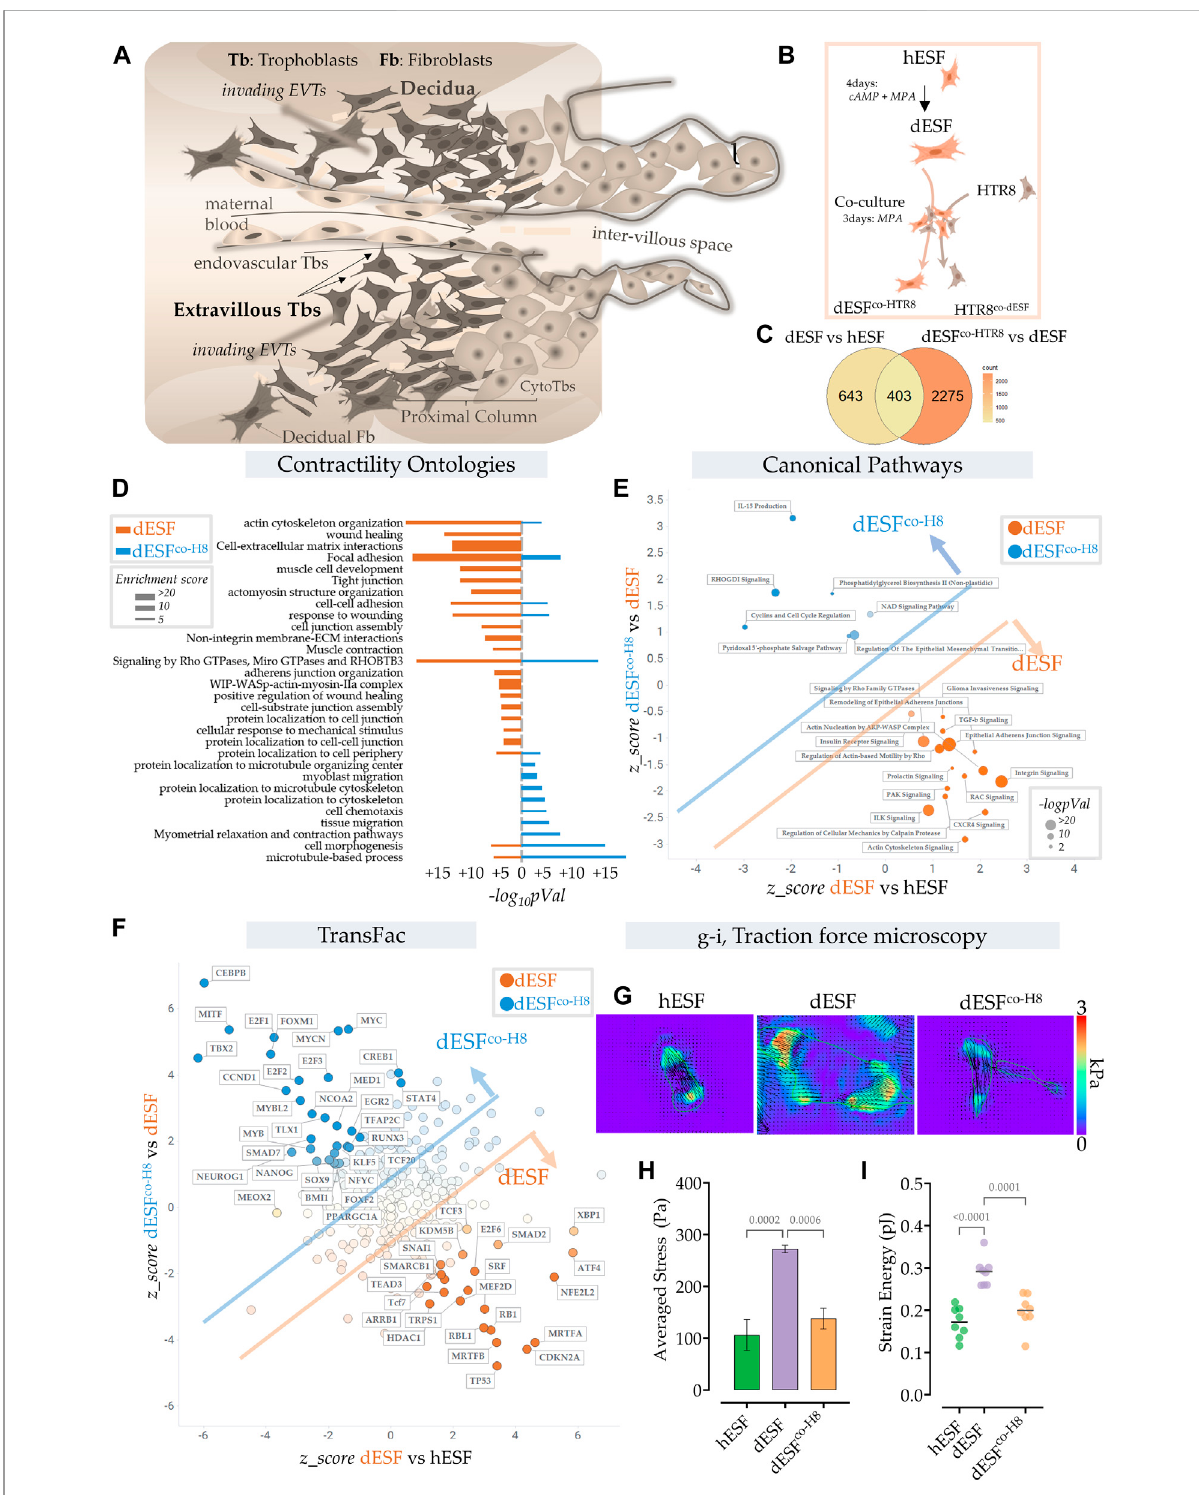
FIGURE 1 Extravillous trophoblasts reduce contractile force generation by decidual endometrial fi broblasts. (A) Schematic showing the maternal fetal interface during placentation, wherein EVTs escape into the maternal stroma and deeply invade into the endometrium to eventually reach the spiral arteries. (B) Schematic showing the experimental plan for co-culture of dESFs with fl uorescently labeled HTR8; cells were separated by fl uorescent assisted cell sorting after 3 days of co-culture and sequenced. (C) Venn diagram showing gene counts differentially regulated between